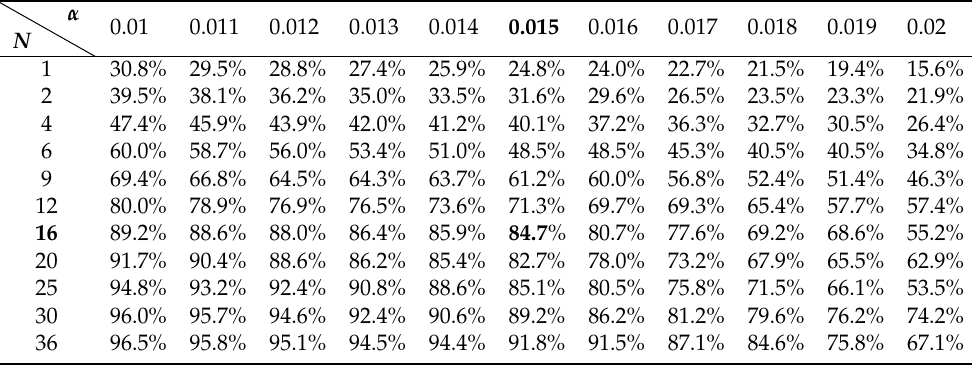
Table A1. The producer accuracy with different α and N . The bold numbers indicate the best param- eters.